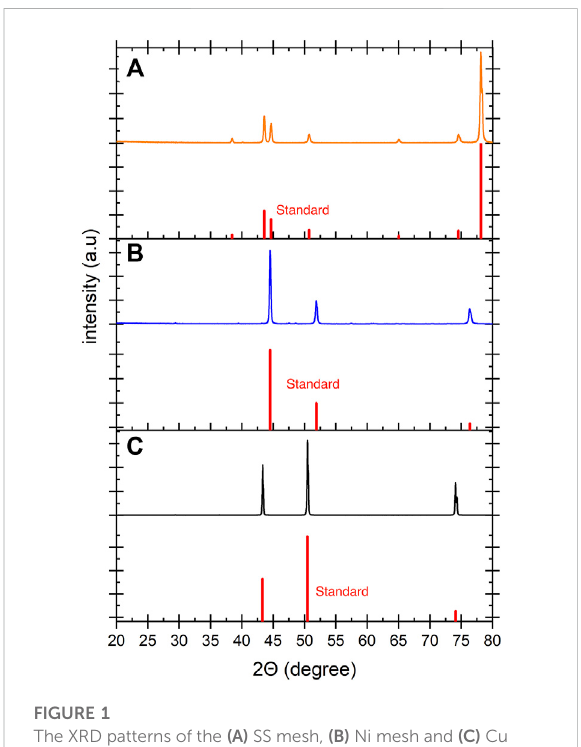
FIGURE 1 The XRD patterns of the (A) SS mesh, (B) Ni mesh and (C) Cu foil before E-WAS. The corresponding peaks con fi rm the crystal structure of the electrodes before electrolysis. The standard XRD patterns are shown in